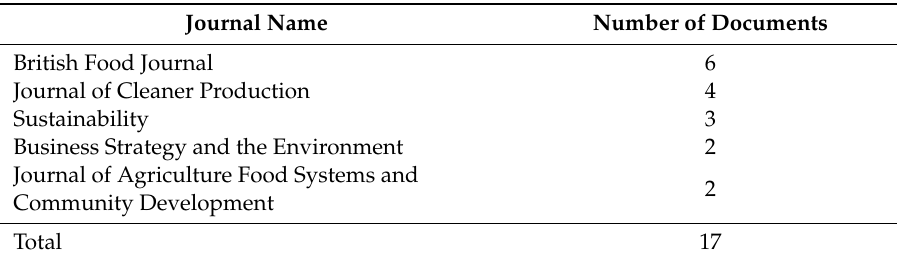
Table 2. Journals with the largest number of documents.